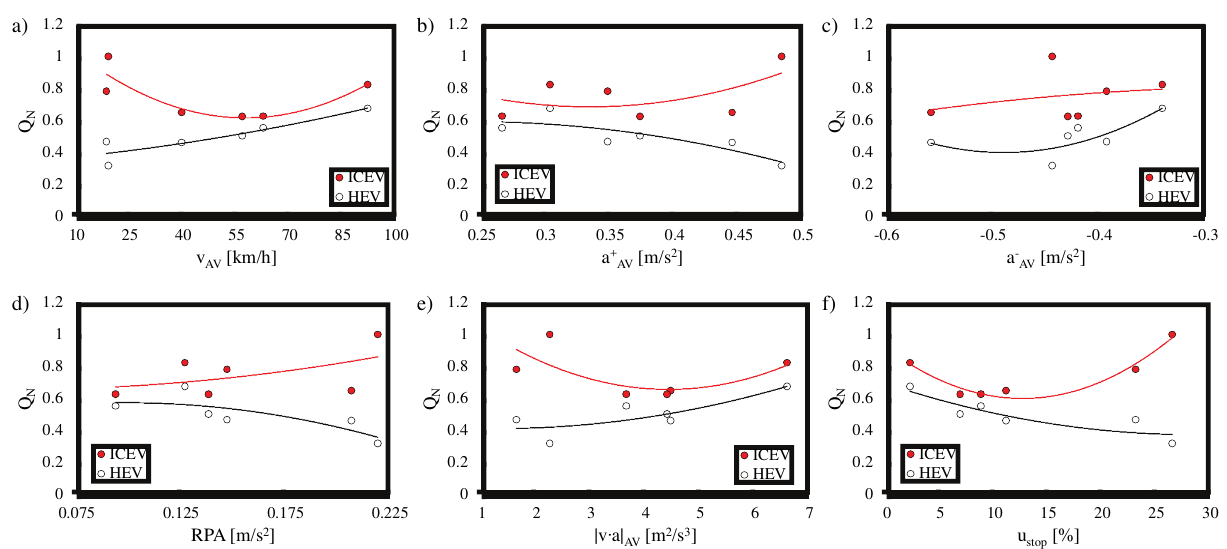
Fig. 1. The dependence of normalized fuel consumption on driving pattern parameters: average speed (a), average acceleration (b), average deceleration (c), relative positive acceleration (d), average absolute value of the product of speed and acceleration (e), time share of vehicle stop